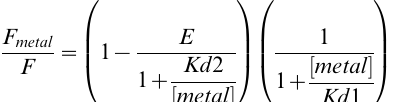
Figure S2 A topology diagram of the iq-mEmerald folding pattern. The b -sheet strands are shown in arrows, a - helices in ribbons, and loops in gray lines. The position of the chromophore is indicated in green and engineered the metal binding histidines are highlighted in red. Figure S3 Example data and fit for fluorescence mea- surements along with the processes to calculate distanc- es. A and B are the fluorescence emission spectra of mEmerald and iq-mEmerald, respectively. The peak intensities are plotted as respect to copper concentrations into C and D. Then the mEmerald quenching data is fitted with a non-specific single binding site equation (shown as the dotted line in C). The fitting result, K d 1 of 161 m M, represents the non-specific quenching of the chromophore by metal solution. Then the quenching of iq- mEmerald is fitted with a two binding site equation (shown as the solid line in D). A binding affinity of 0.19 m M and FRET efficiency of 0.77 are obtained from the fitting. Lastly, the distance (10.7 A˚ ) between the chromophore of iq-Emerald and the metal ion is calculated using the Fo¨rster equation and reported in Table S1. Figure S4 Comparison of the pH dependence of mEm- erald (blue) and iq-mEmerald (red). 500 nM of each protein was incubated with different pH buffer solutions. No difference in the pH dependence of fluorescence was observed in